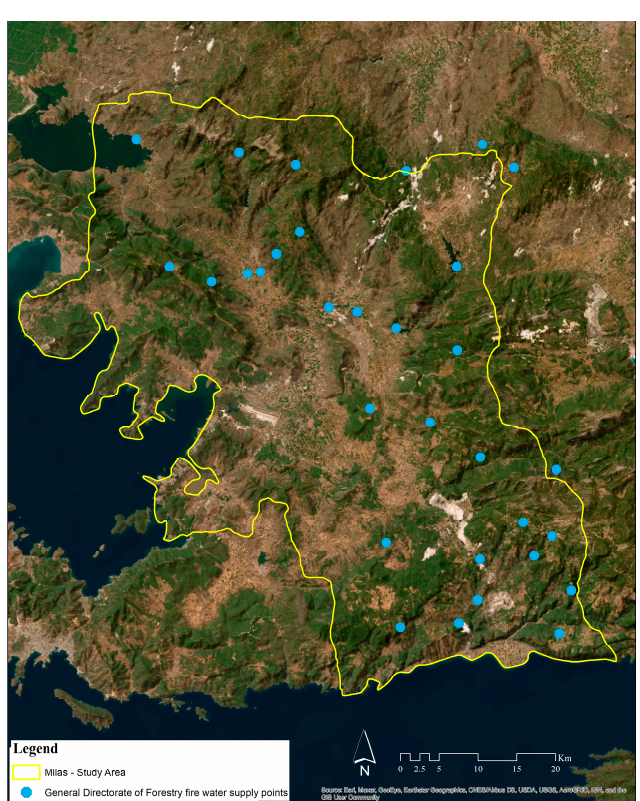
Figure 15. Fire water supply points of GDF.